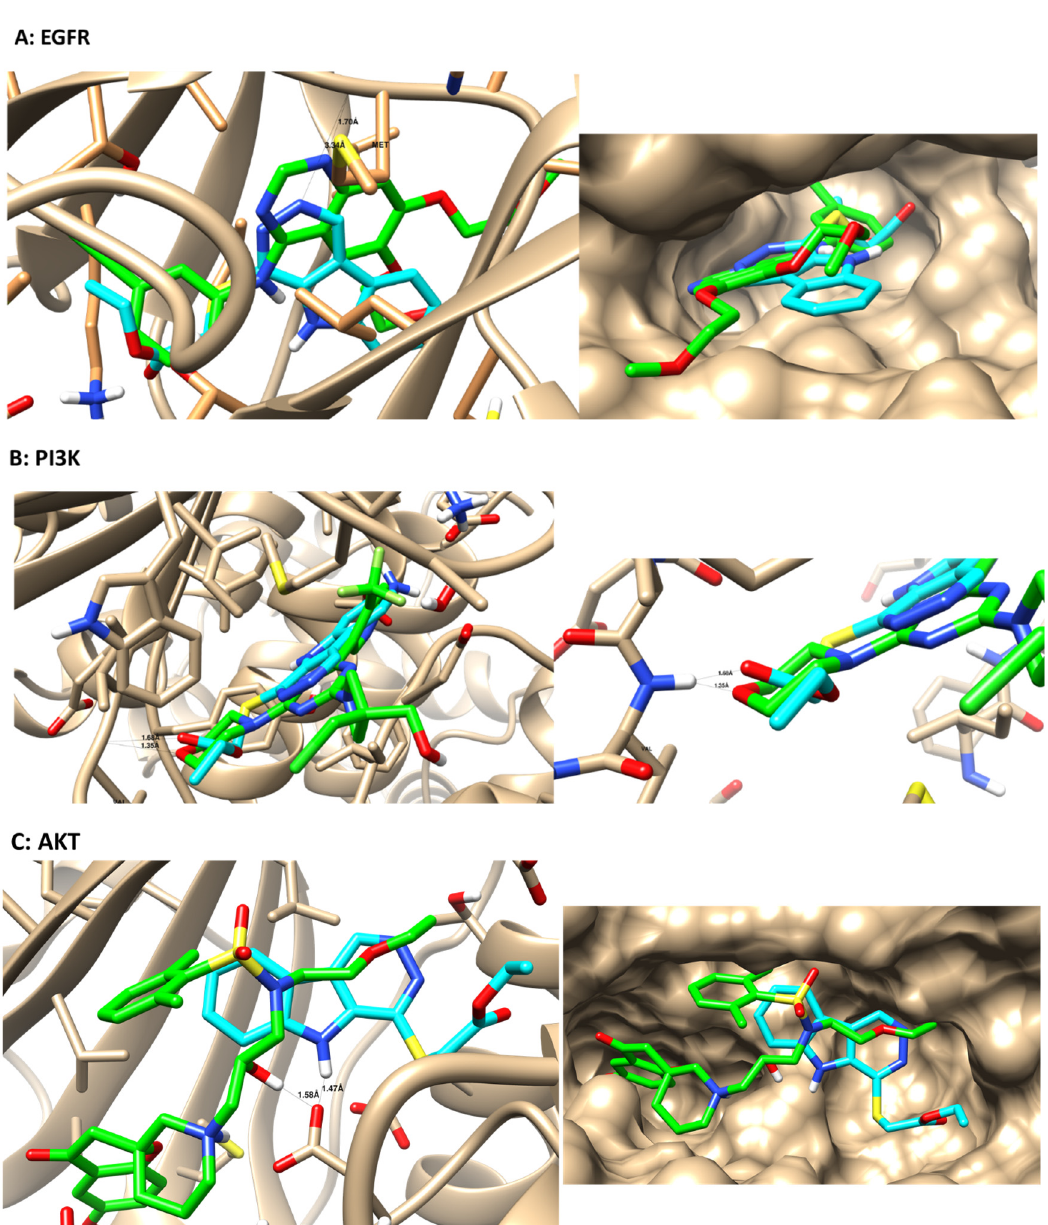
Figure 6. Binding disposition and ligand–receptor interactions between the cocrystallized ligand (green-colored) and docked compound 6 (cyan-colored) inside the three proteins of EGFR (PDB = 1M17), PI3K (5JHB), and AKT (PDB = 3QKK). The 3D images were obtained using Chimera. Compound 6 and the cocrystallized ligands are compared for highlighting the interaction binding mode inside the protein active sites and the lipophilic interactions with lipophilic amino